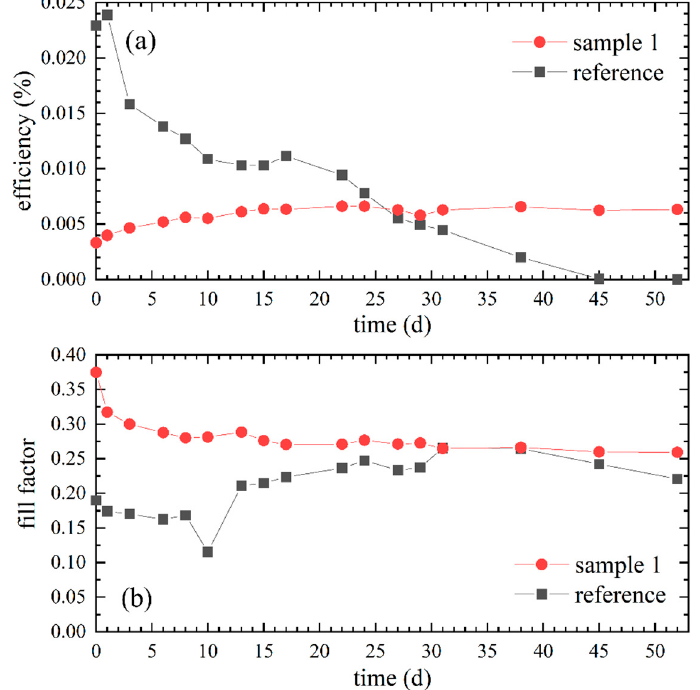
Figure 6. Comparison of sample 1 with 17.4 wt% PEO to the reference with a commercial liquid electrolyte: ( a ) Efficiency values over 52 days; ( b ) Temporal progressions of the related fill factors.